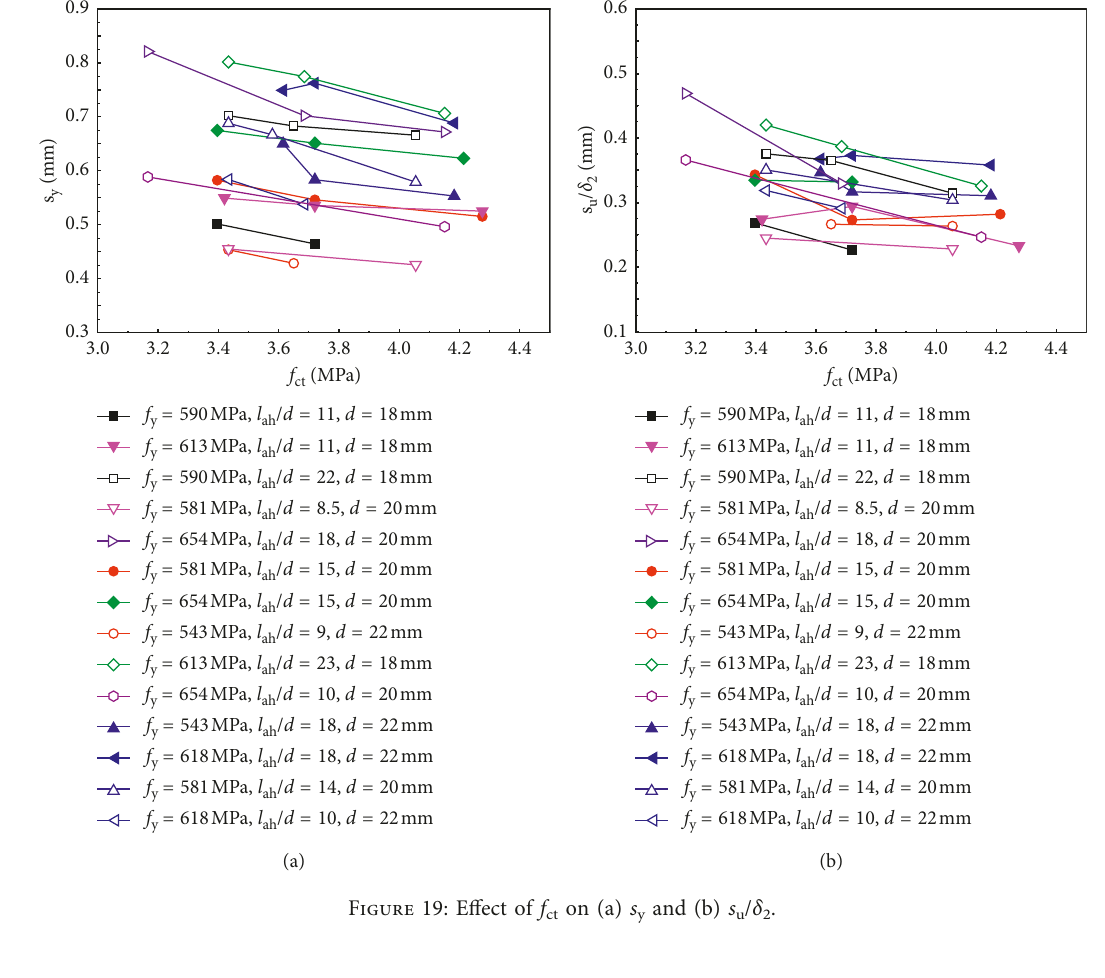
Figure 19: Effect of f ct on (a) s y and (b) s u / δ 2 .